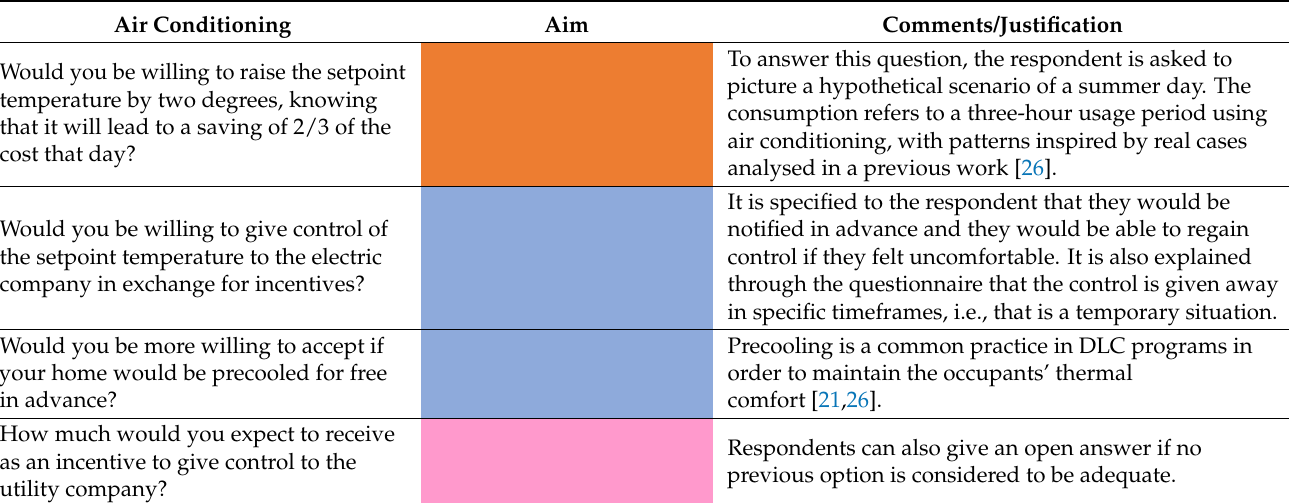
Table 5. Questionnaire—air Conditioning section. Beforehand, the respondent was asked whether they have electrical heating and/or heating system in their home. For the colour legend and the corresponding sub-objectives, please refer to Table 1.